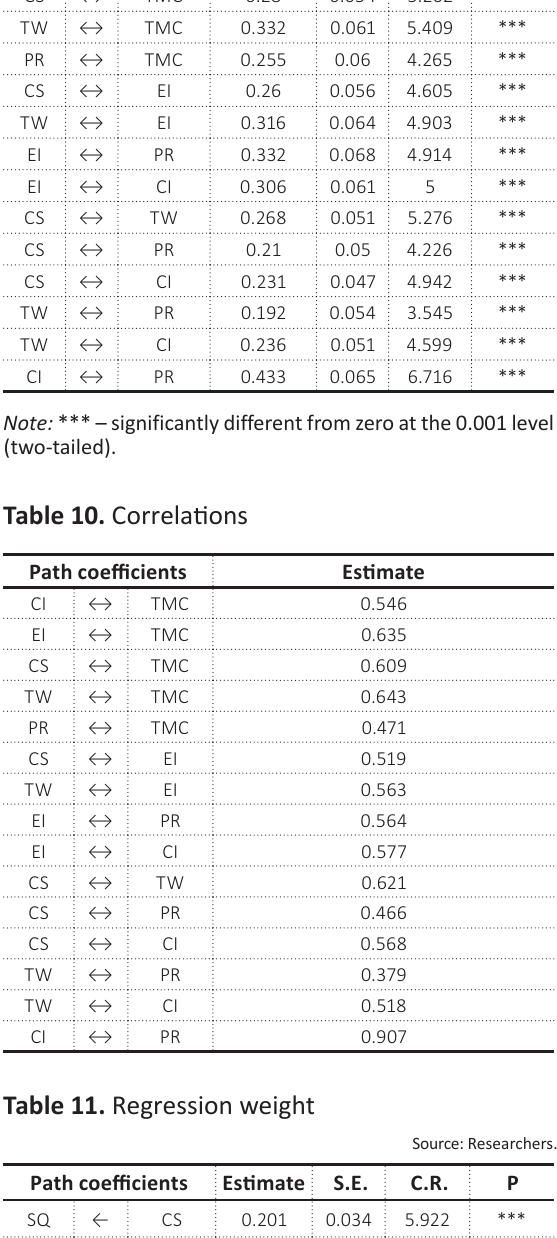
Table 13. Standardized Regression Weights